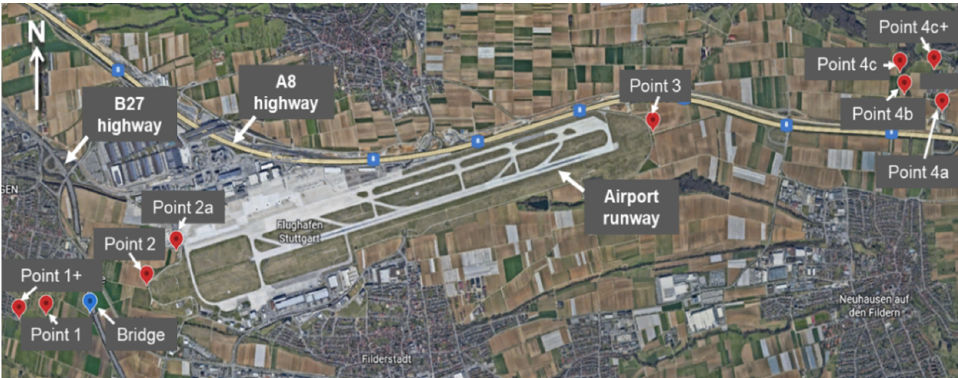
Figure 1. An overview of the measurement locations during the campaign.